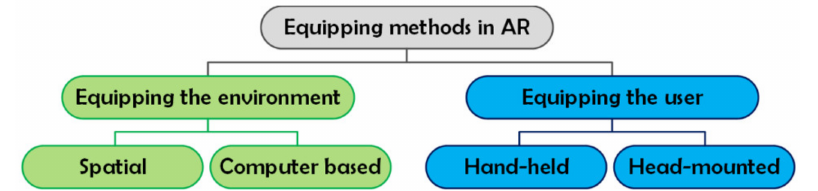
Figure 6. Methods of AR application.